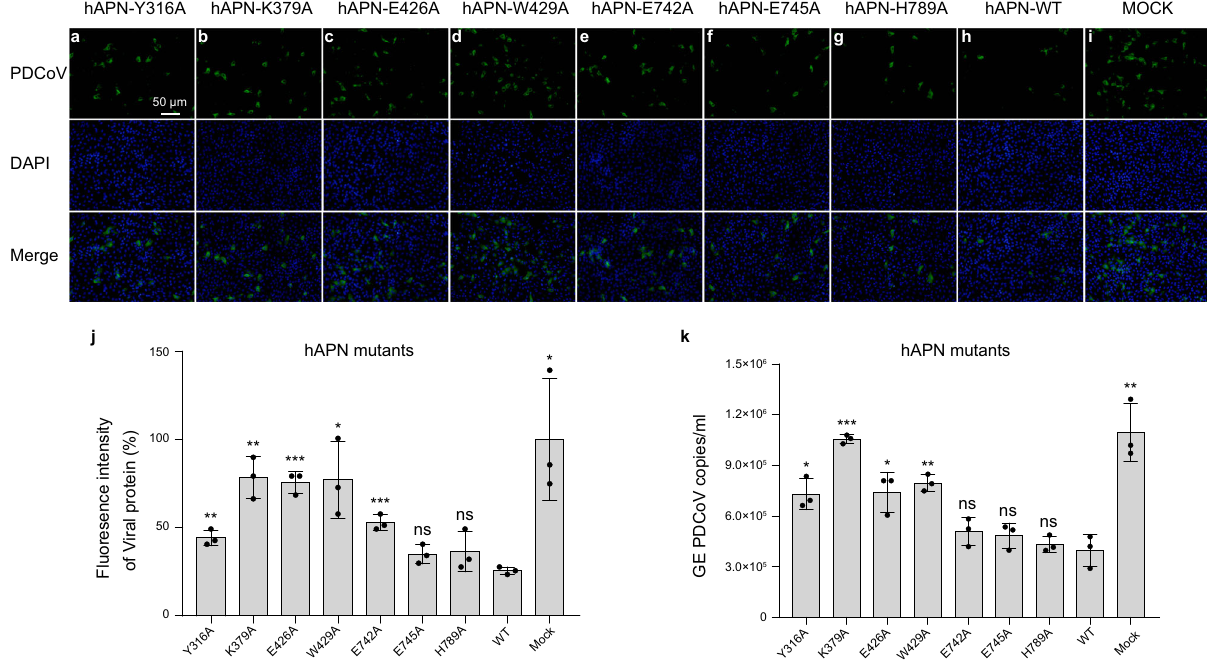
Fig. 5 Y316, K379, E426, and W429 are the key residues on hAPN that inhibit PDCoV replication. a – i PDCoV (MOI = 0.1) was preincubated with soluble wildtype or mutant hAPN proteins at a concentration of 80 μ g/ml at 37 °C for 1 h, then the virus-APN protein mixtures were added onto a monolayer of LLC-PK1 cells in 24-well plates. After incubation at 4 °C for 1 h, the plates were washed twice with PBS and then cultured in DMEM containing 7.5 μ g/ml trypsin at 37 °C with 5% CO 2 . At 8 h post-infection (hpi), the samples were subject to immuno fl uorescence assay (IFA). Porcine polyclonal antibodies were used to detect PDCoV (green), and cell nuclei was stained with DAPI (blue). Scale bar, 50 μ m. j The fl uorescence intensity in a – i was determined by software Image J version 1.52i. Data are expressed as mean ± SD, n = 3. Error bars denote standard deviations for triplicate samples. An unpaired two-tailed t -test was used to determine the statistical signi fi cance. * p < 0.05; ** p < 0.01; *** p < 0.001; ns no signi fi cance. k At 2 hpi, the samples from a – i were collected for RT-qPCR to determine the PDCoV genome equivalents (GE). Data are expressed as the mean ± SD, n = 3. Error bars denote standard deviations for triplicate samples. An unpaired two-tailed t -test was used to determine the statistical signi fi cance. * p < 0.05; ** p < 0.01; *** p < 0.001; ns no signi fi cance. Values for fl uorescence intensity and GE are provided as a Source Data fi